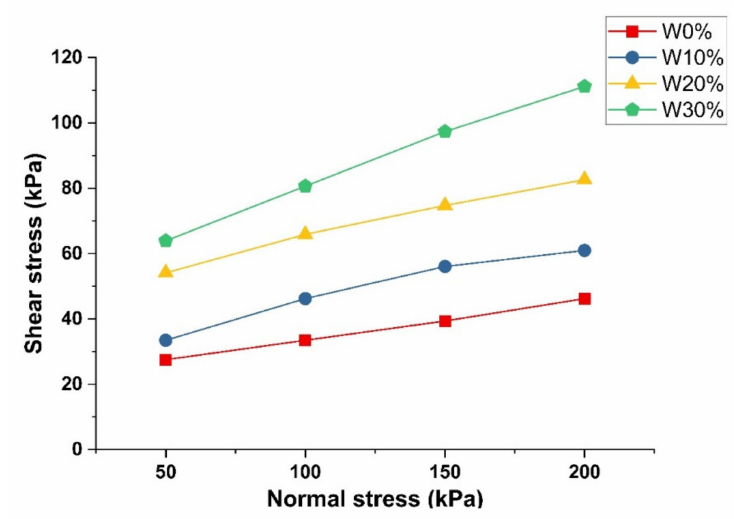
Figure 10. DS test result (Note: W represents C&D waste).